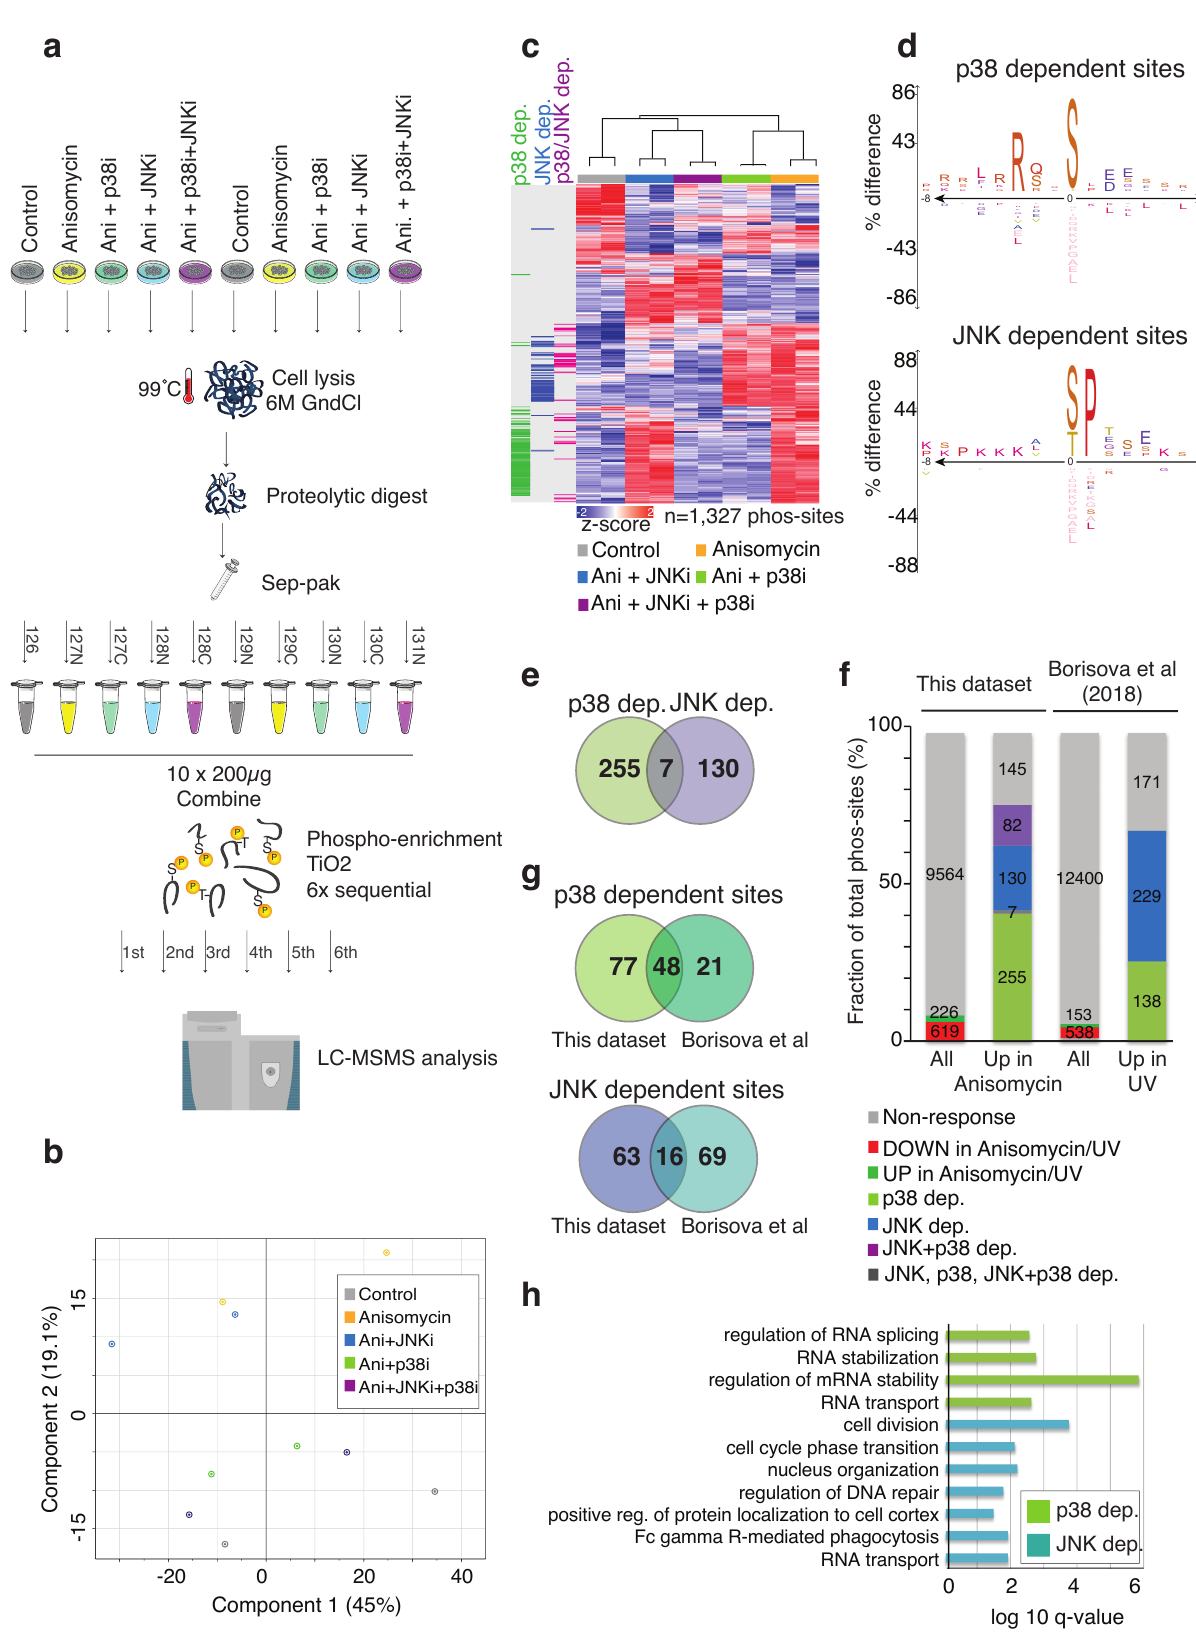
Figure 1. Phospho-proteomic analysis of p38- and JNK-dependent phosphorylation reactions. ( a ). Schematic of phospho- proteomic workflow. U2OS cells were treated in duplicates with indicated combinations of anisomycin (Ani, 1 h) and p38 and JNK inhibitors (p38i, JNKi, 0.5 h pre-treatment). Lysates were digested with trypsin and peptides were labeled